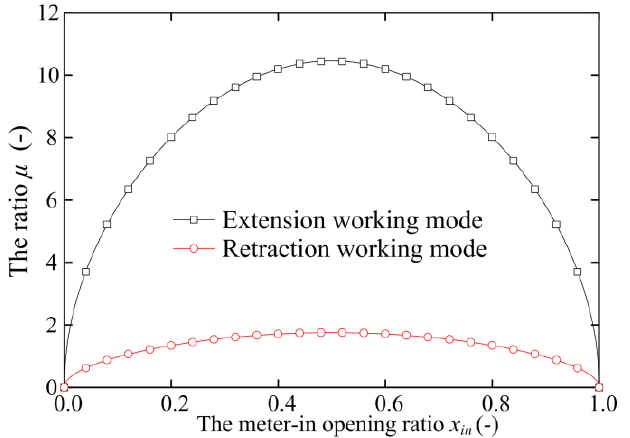
Figure 27. The variations of the velocity v of the cylinder piston of HPCIMS.